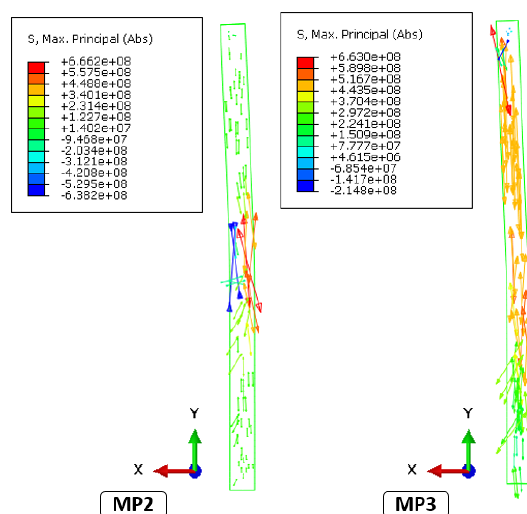
Figure 15. Distribution and direction of the main stresses in the anchors of models MP2 and MP3 (Stresses in Pa).